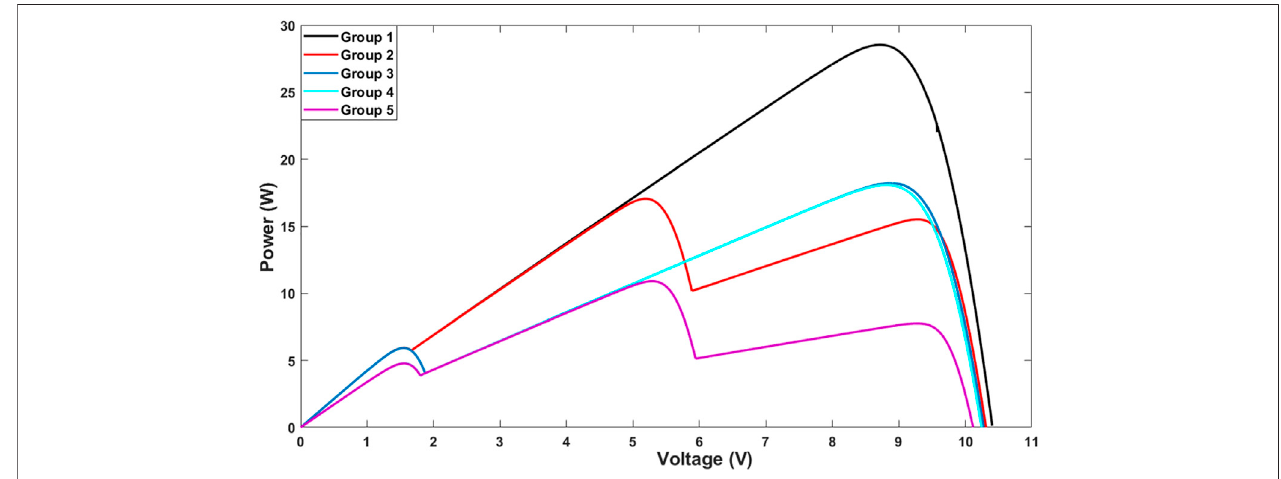
FIGURE 4 | P-U characteristic curve of different illumination intensity under shielding condition.